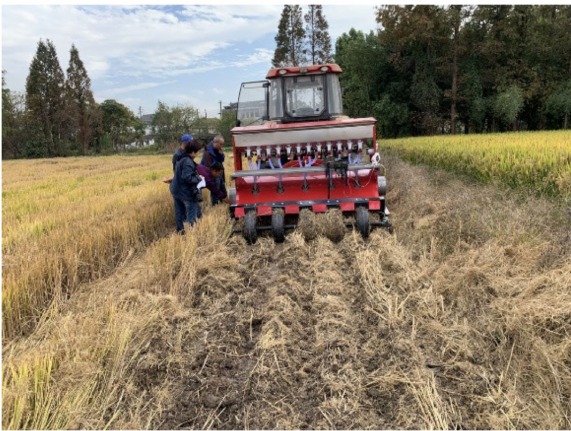
Figure 4. Existing problems with straw back throwing and strip